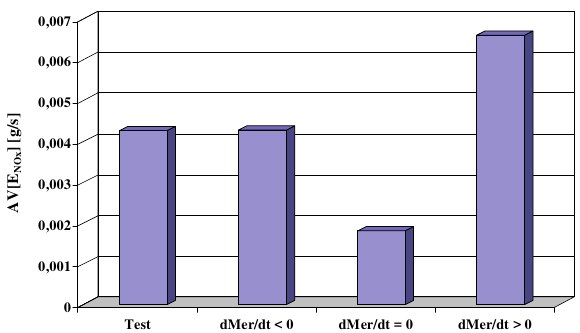
Fig. 22. Mean value of the carbon monoxide exhaust emission in the Malta Fig. 26. Mean value of the nitrogen oxides exhaust emission in the Malta test and in the states corresponding to the negative, zero and positive test and in the states corresponding to the negative, zero and positive values of the engine torque derivative with respect to time values of the engine torque derivative with respect to time